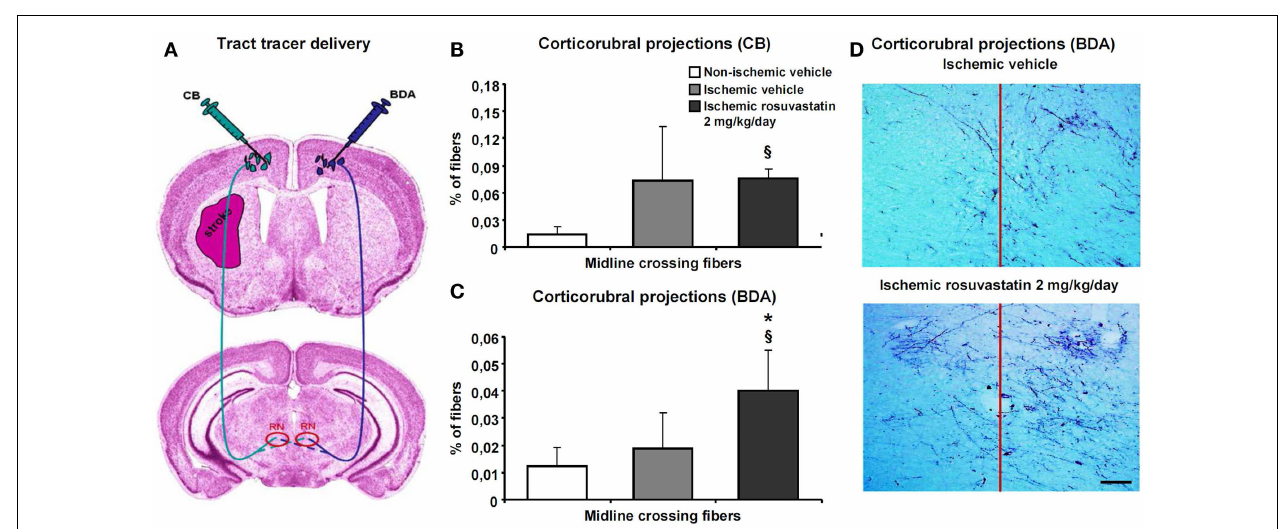
percentage of midline-crossing fibers originating from the ipsilesional pyramidal tract (B) , but increases the percentage of contralesional pyramidal tract fibers growing out across the midline in direction to the ipsilesional red nucleus (C) . (D) Microphotographs of representative vehicle-treated and rosuvastatin-treated ischemic mice illustrating BDA traced corticorubral fibers crossing the midline in between both red nuclei. Note that the ipsilesional (left) red nucleus receives more BDA traced fibers after rosuvastatin than vehicle delivery. Data are mean values ± SD ( n = 10 animals/group). § p < 0.05 compared with non-ischemic vehicle; * p < 0.05 compared with ischemic vehicle. Bar, 100 µ m.